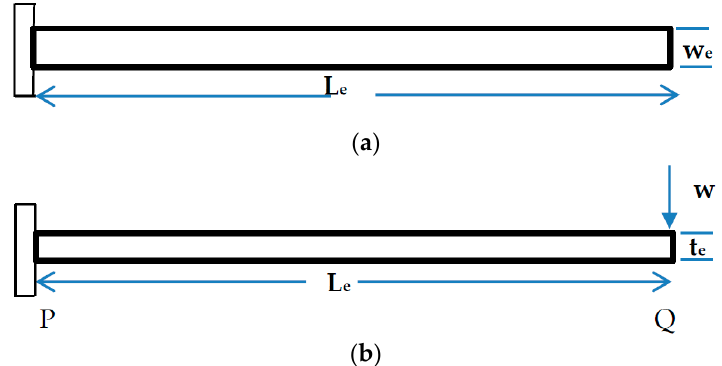
Figure 6. ( a ) Plan view of cantilever model of the leaf spring; ( b ) Elevation view of cantilever model of the leaf spring.